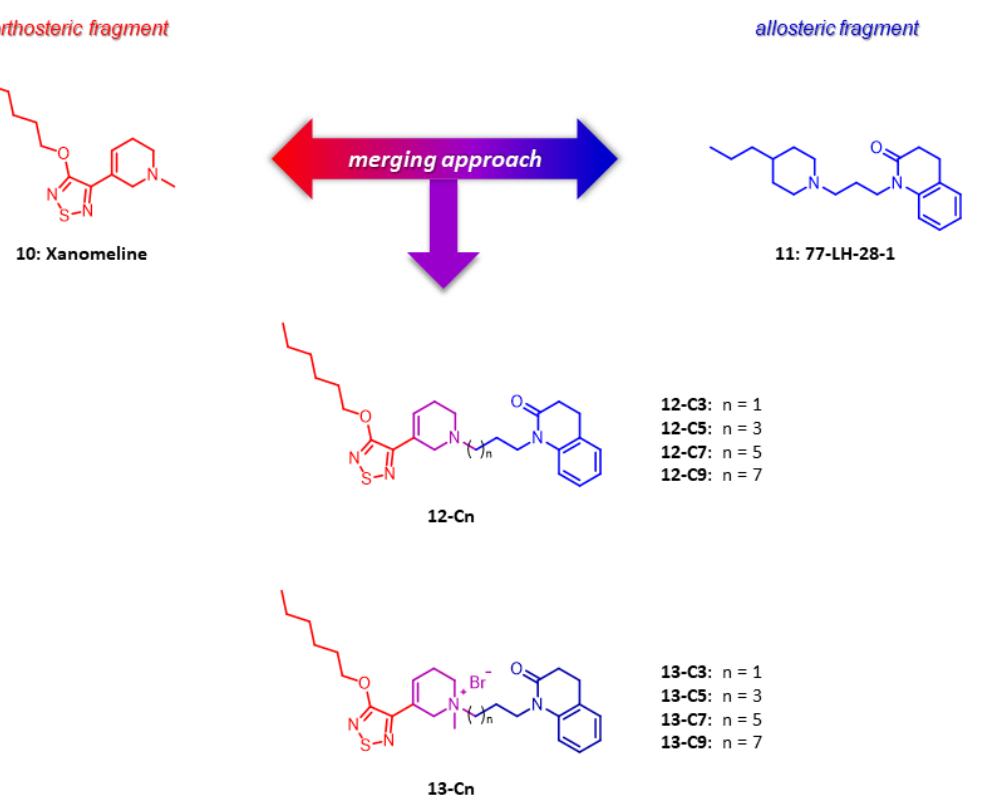
Figure 2. Design of the target Xanomeline/77-LH-28-1 hybrid compounds 12-Cn ( 12-C3 , 12-C5 , 12-C7 , and 12-C9 ) and 13-Cn ( 13-C3 , 13-C5 , 13-C7 , and 13-C9 ) derived from merging the orthosteric ligand Xanomeline ( 10 ) with the allosteric modulator 77-LH-28-1 ( 11 ).